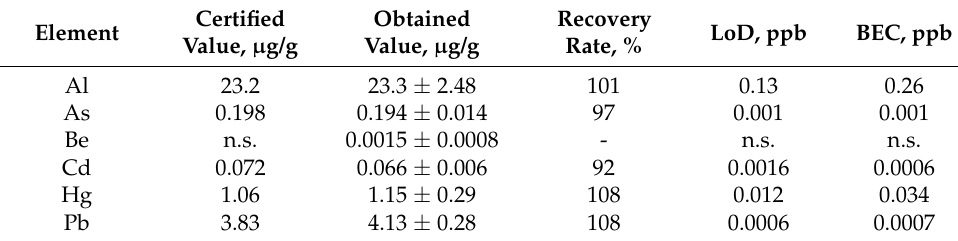
Table 1. Laboratory quality control with certified reference material of human hair